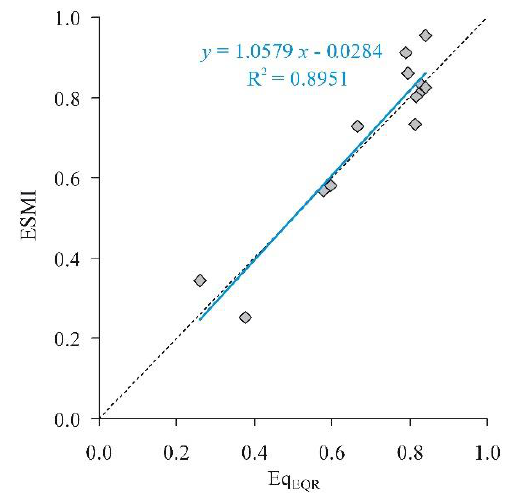
Figure 4. Correlation between the ESMI calculated for 11 lakes in the vicinity of Olsztyn surveyed in 2016 with the original method ESMI [19] and the proposed Eq formulas (based on colonization index Z , maximum colonization depth C max and mean Secchi disc visibility in summer). Table 7. Values of the Ecological Status Macrophyte Index ESMI (after Dunalska et al. [19]) and Eq EQR in lakes in vicinity Olsztyn in the growing season of 2016.